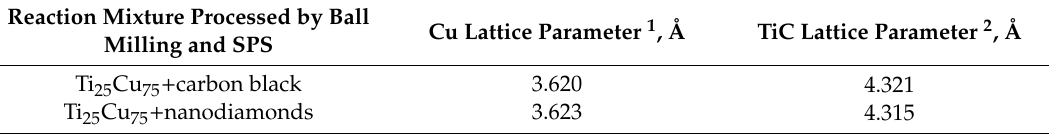
Table 1. Lattice parameters of the phases of the sintered TiC–Cu composites.